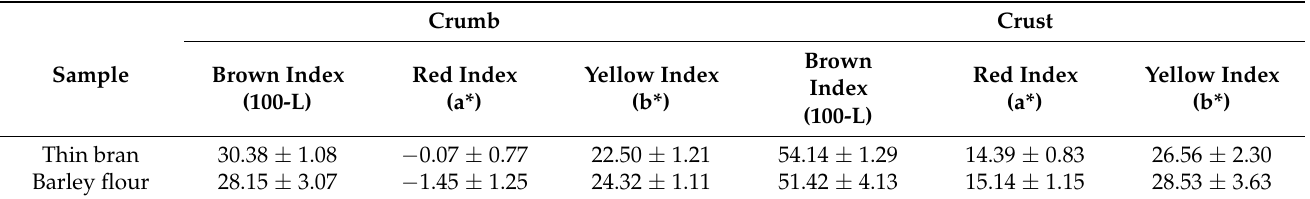
Table 14. Evaluation of colorimetric parameters of the bread samples based on different types of supplementation, as determined by the two-factor ANOVA (analysis of variance) (data are means ± standard